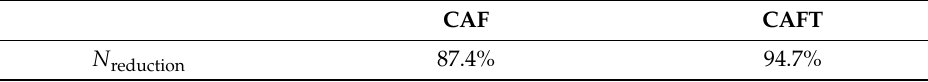
Table 5. N reduction for CAF and CAFT as compared to CA.